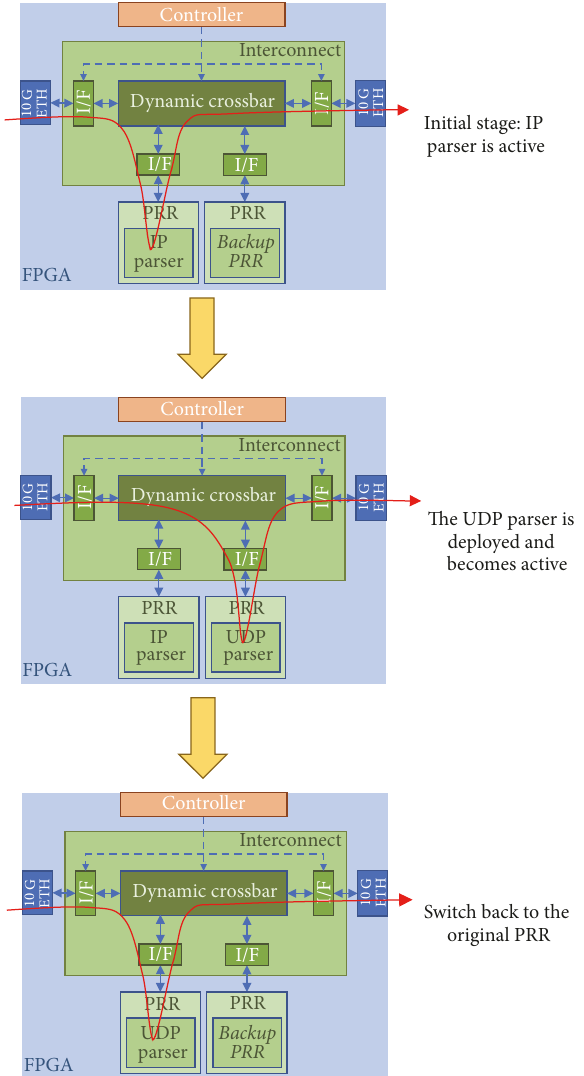
Figure 12: The demonstrated reconfiguration process.